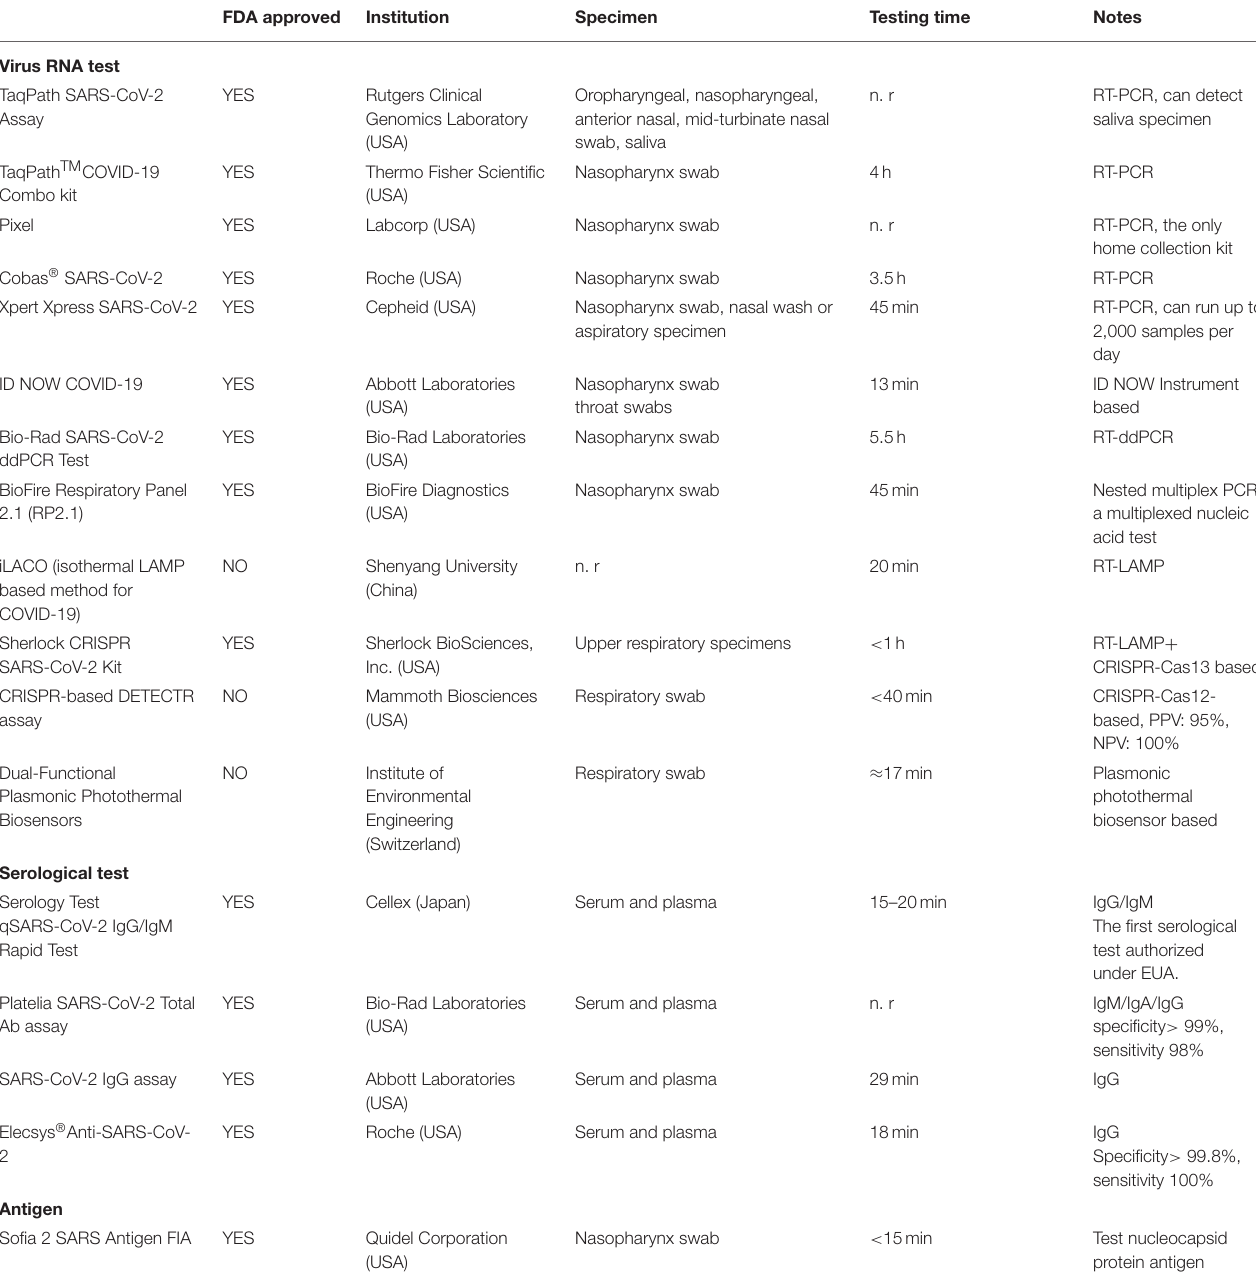
TABLE 1 | Diagnostic methods for